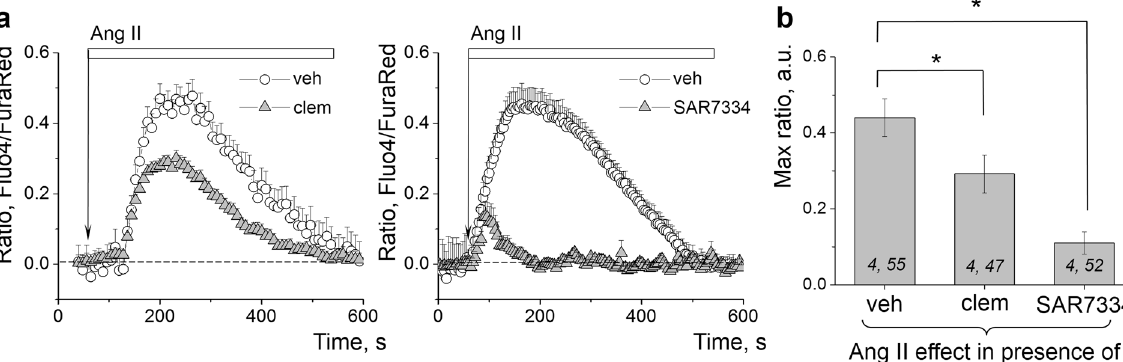
Figure 8. The involvement of TRPC6 channels into the Ang II–dependent calcium influx in the podocytes. ( a ) Representative effects of the TRPC channel blockers clemizole hydrochloride (Clem, 5 µ M, 10 min) and SAR7334 (1 µ M, 10 min) on Ca 2 + transients evoked in the podocytes with 10 µ M Ang II. ( b ) Graph summarizing the effects of Ang II on calcium influx in the podocytes in presence of clemizole and SAR7334. ( i , j ) noted on graph is number of animals ( i ) and podocytes ( j ) analyzed in each group. * P < 0.05 versus Ang